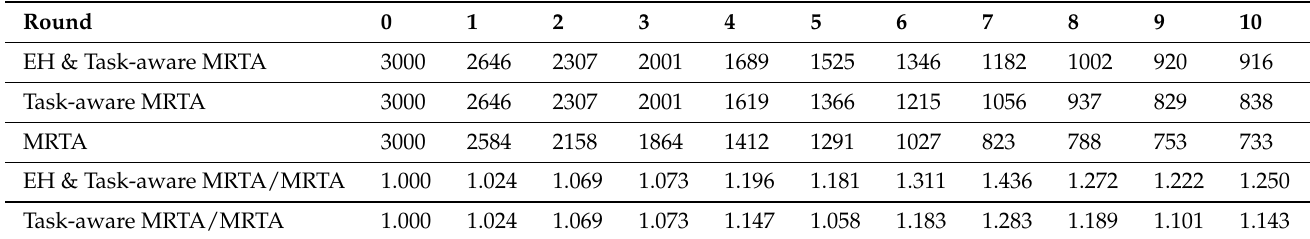
Table 2. Total remaining energy in the batteries of the five robot nodes which are located initially as given in Figure 2 versus the number of rounds under i.i.d. EH processes.